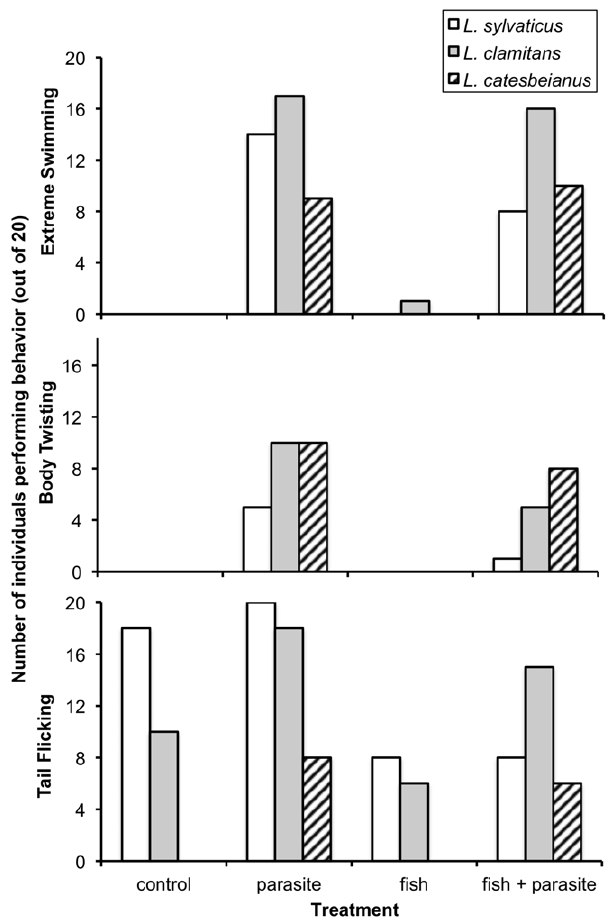
Figure 3. Additional behaviors performed by tadpoles of the three species to four different treatments. Number of tadpoles engaged in a) extreme swimming, b) body twisting, and c) tail flicking behavior post-treatment. See text for behavior descriptions. N=20 for each treatment combination and data were treated as binomial (i.e. individual in replicate did (score=1) or did not (score=0) perform behavior). For both extreme swimming and body twisting, species differed significantly and there was a significant effect of parasite. In body twists, the effect of fish was also significant. For tail flicking, significant species by parasite and species by fish interactions occurred. All effects are based on generalized linear analysis (see text for details).